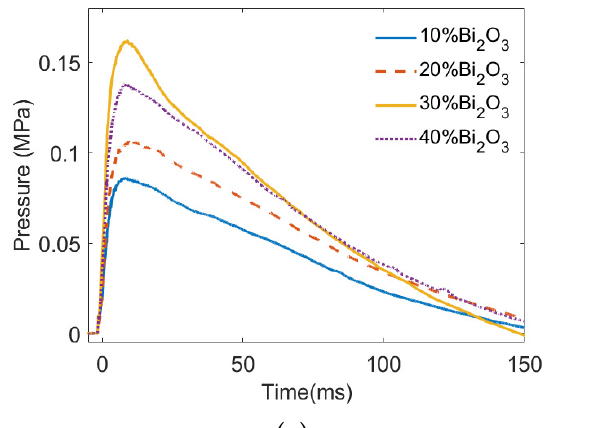
Figure 4. The pressure varied with time in the test chamber: ( a ) PTFE/Al/Bi 2 O 3 ; ( b ) PTFE/Al/MoO 3 . The pressurization characteristics of PTFE/Al/oxide are listed in Table 3. The quasi- static pressure peak ( P max ), impulse, and duration time were used to characterize the pres- surization and energy release performance of the PTFE/Al/oxide energetic materials. The experiments showed that when the impact velocity ranged from 904 m/s to 971 m/s, the